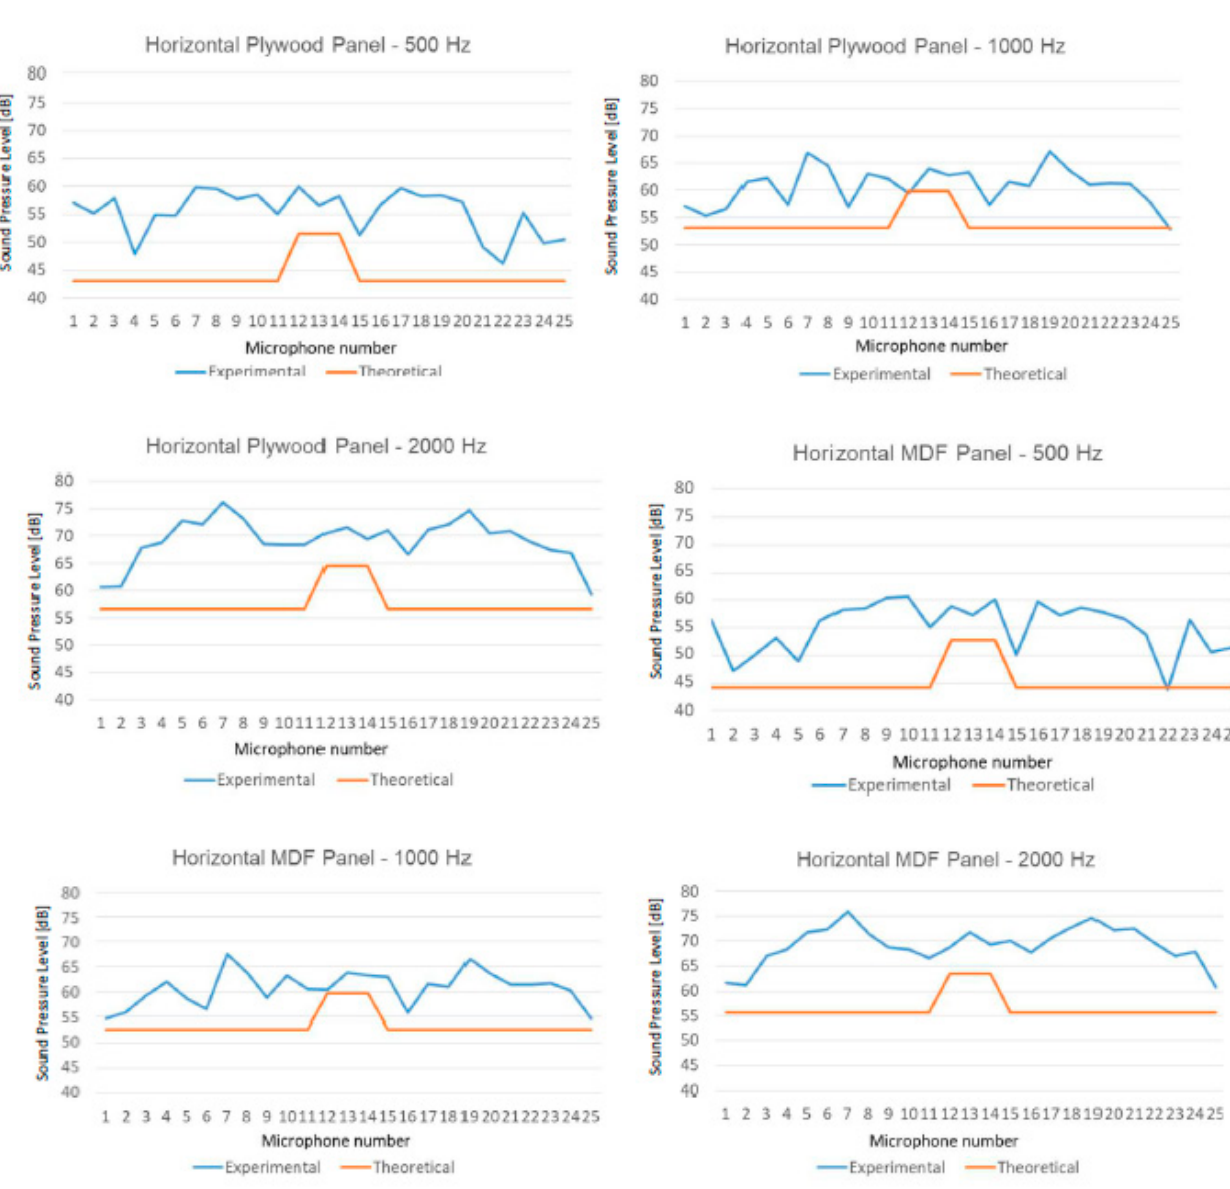
Figure 9. Matching between numerical and experimental data for the horizontal plywood and MDF panels inside Room A at mid-frequencies.